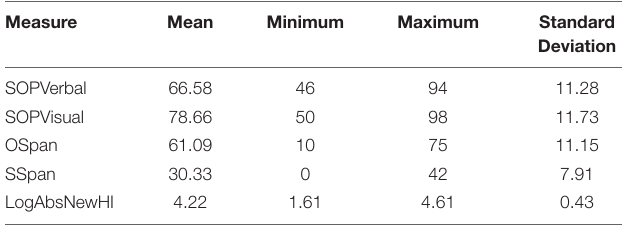
TABLE 1 | Mean, Minimum, Maximum, and Standard Deviation Values for Each of the Five (SOPVerbal and SOPVisual for SOP) Individual Difference Measures of American Participants.